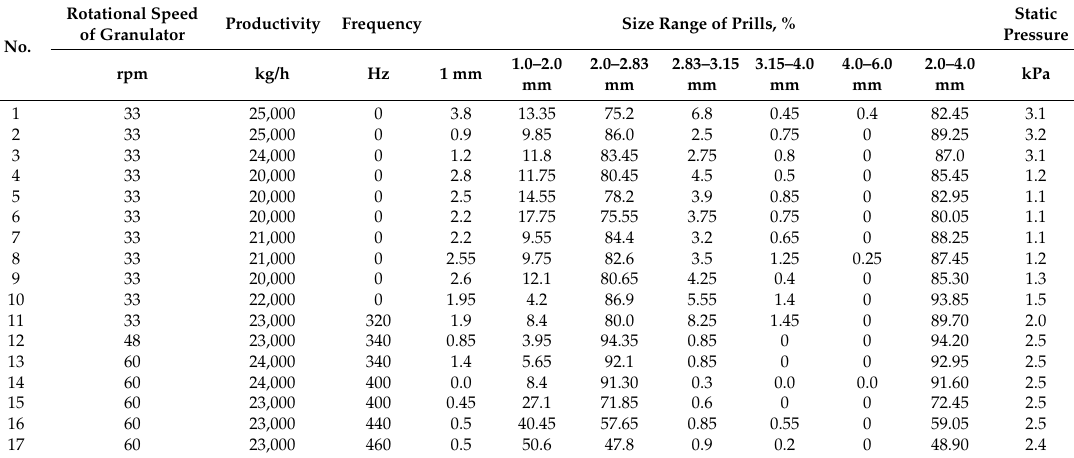
Table 3. Results of industrial